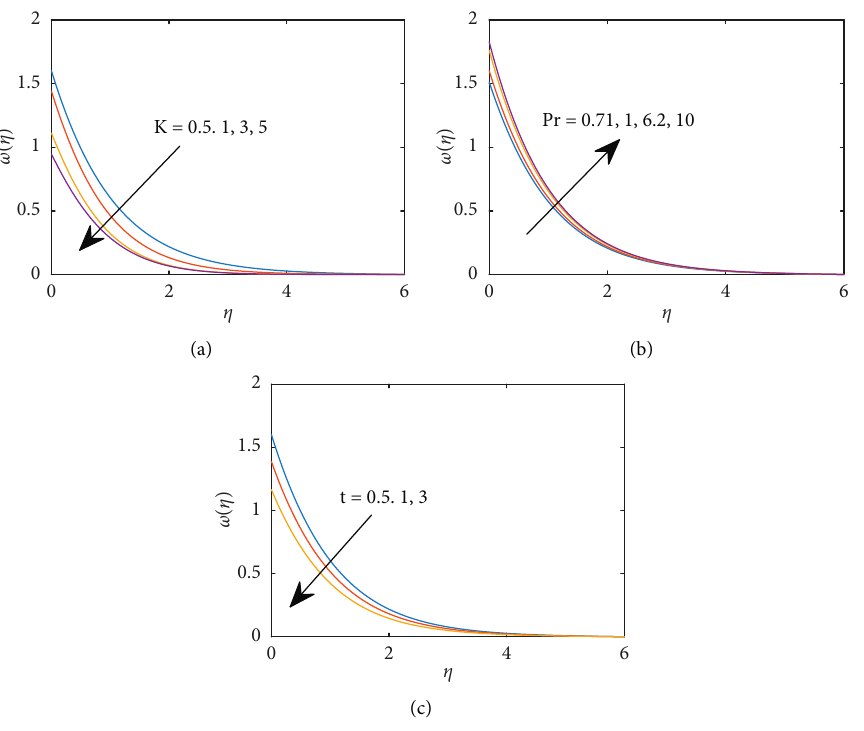
Figure 11: Impact of (a) K